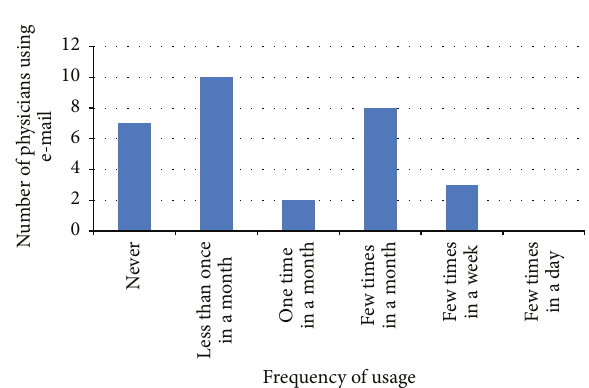
Figure 2: Line/mobile usage.